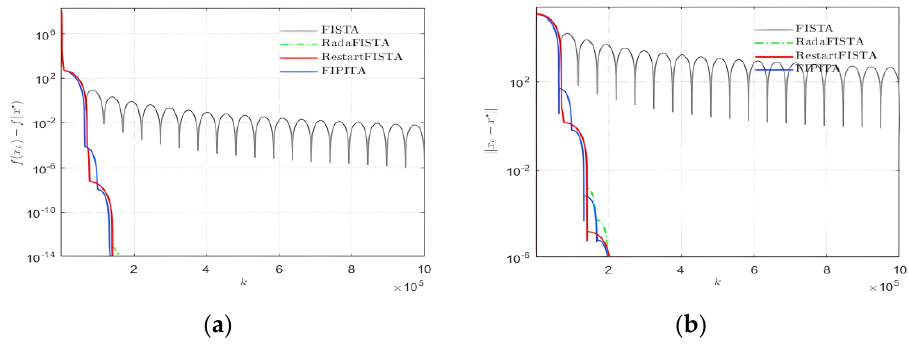
Figure 10. Iteration times and convergence. ( a ) f ( x k ) − f ( x ∗ ) ; ( b ) || x k − x ∗